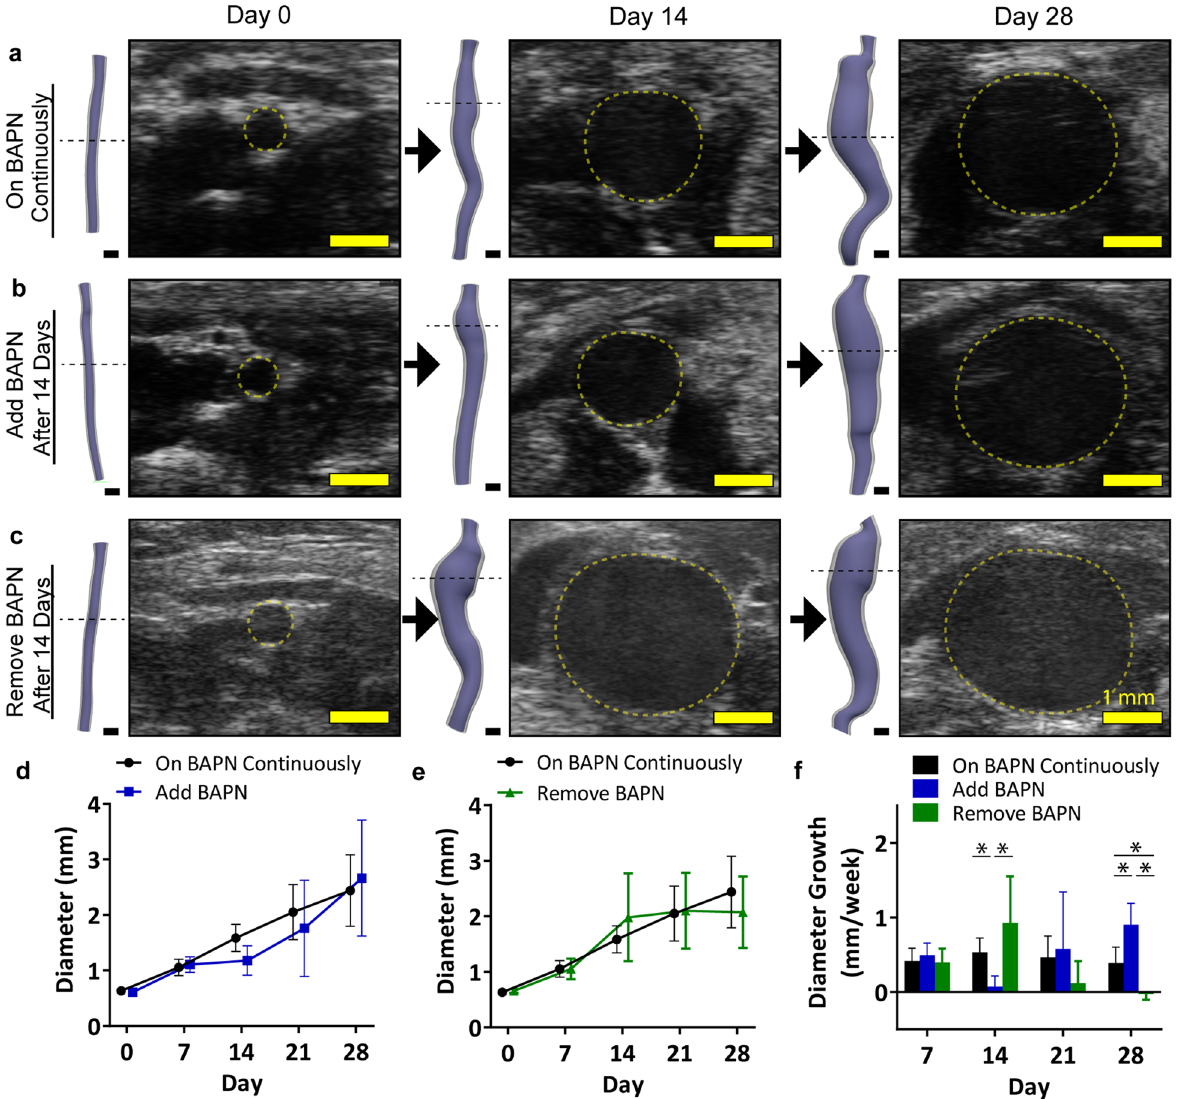
Figure 5. Effects of altering timeline of BAPN administration. Even after aneurysm formation, BAPN administration was necessary for continued aneurysmal expansion. Representative ultrasound and volumetric segmentations demonstrate the lack of growth from Day 14 to Day 28 observed in ( a ) the mice treated with BAPN continuously compared to ( b ) the Add BAPN group and ( c ) the Remove BAPN group. Quantification of maximum effective diameter demonstrates that ( d ) the addition of BAPN causes growth and ( e ) the removal of BAPN inhibits growth. ( f ) Growth rate shows similar results. Scale bars are 1 mm. * p < 0.05 with lines indicating the